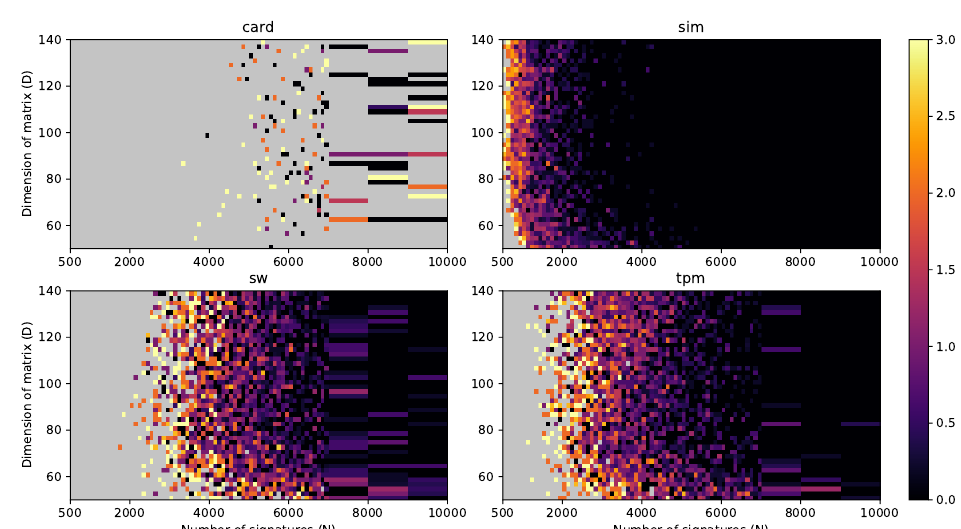
Figure 12: Heatmap of average minimal amount of fixed errors required for attack success. Babai’s nearest plane algorithm with recentering and geometric bounds was used. Gray color marks areas where none of the attack tries succeeded.